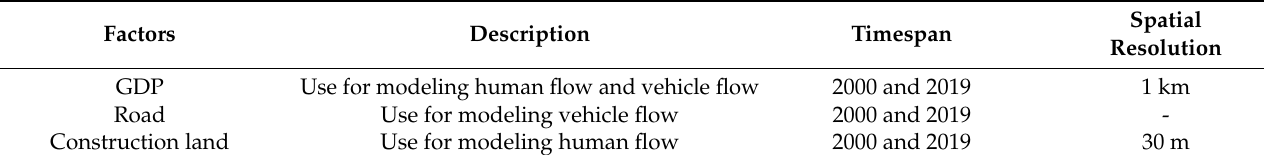
Table 2. Information about the factors used for modeling indices of mobile human activity.